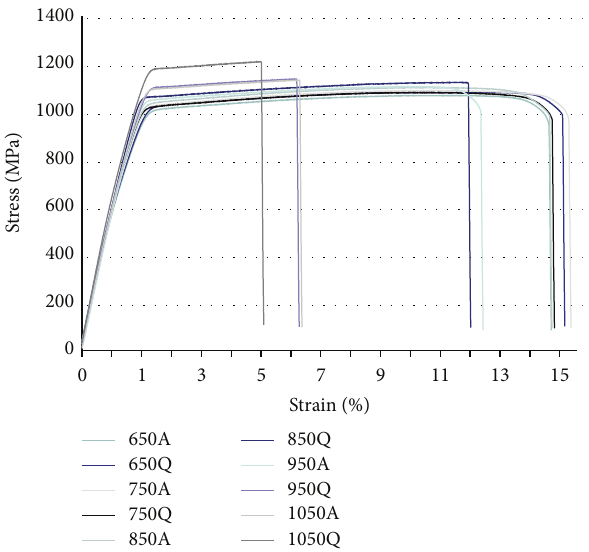
Figure 8: Stress-strain curve of heat-treated Ti6Al4V following both annealing and water quenching from different